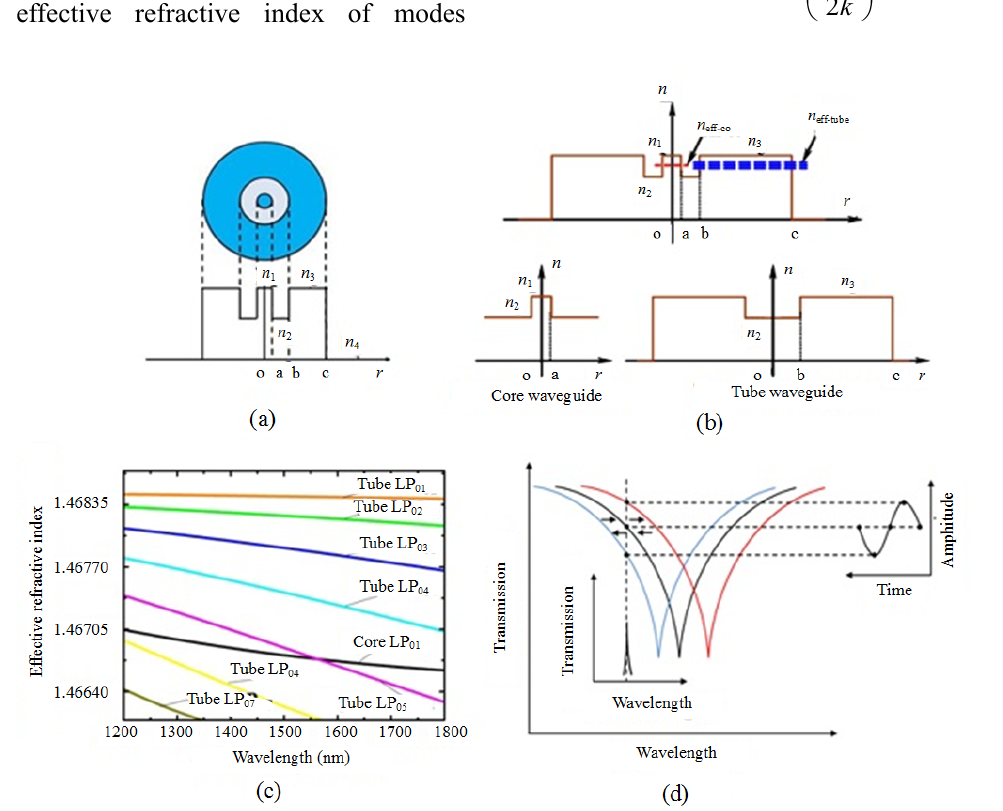
Fig. 1 Schematic diagram of (a) refractive index profile of double-cladding fiber and (b) the equivalent coaxial waveguides: core waveguide and tube waveguide; (c) the calculated effective refractive index of modes in the rod waveguide and the tube waveguide ( a = 4 μ m, b = 13 μ m, c = 62.5 μ m, n 1 = n 3 = 1.4685, n 2 = 1.4665); (d) the diagram of intensity variation at a fixed wavelength due to the wavelength shift of spectrum subjected to acoustic